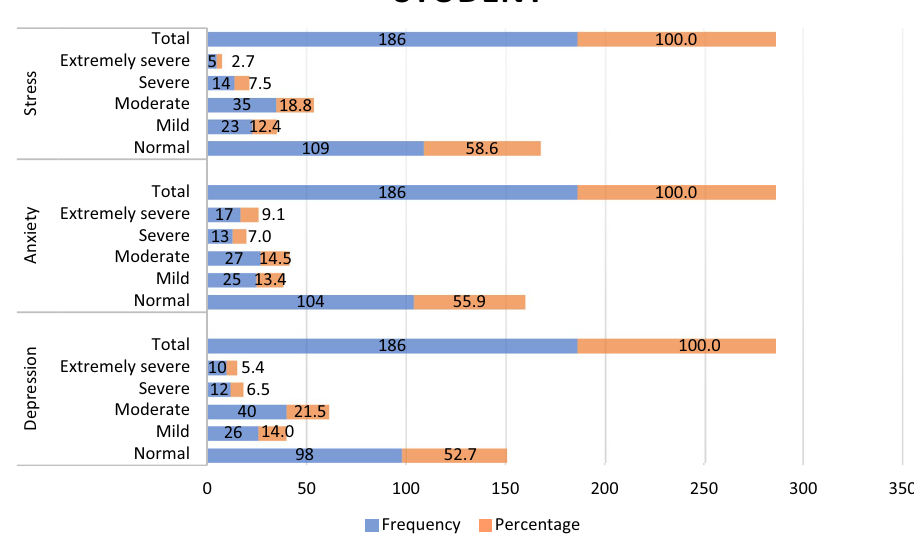
Figure 1. Distribution of dental students according to their levels of Depression, Anxiety and Stress.